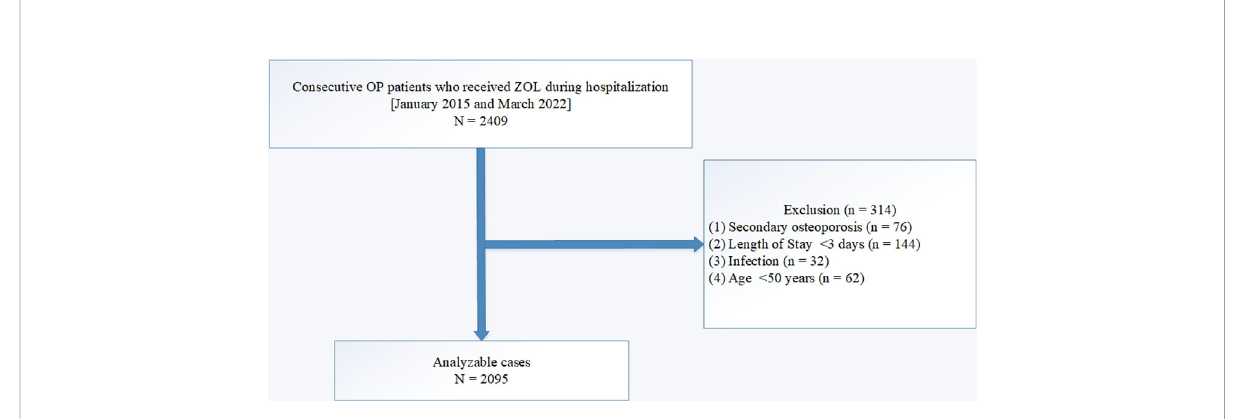
FIGURE 1 A schematic of our study